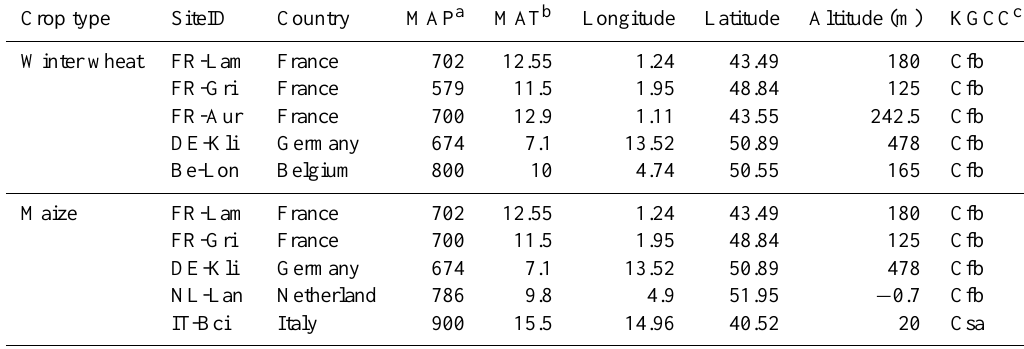
Table 1. Basic geography and climate information for different crop sites. Crop type SiteID Country MAP a Longitude Winter wheat